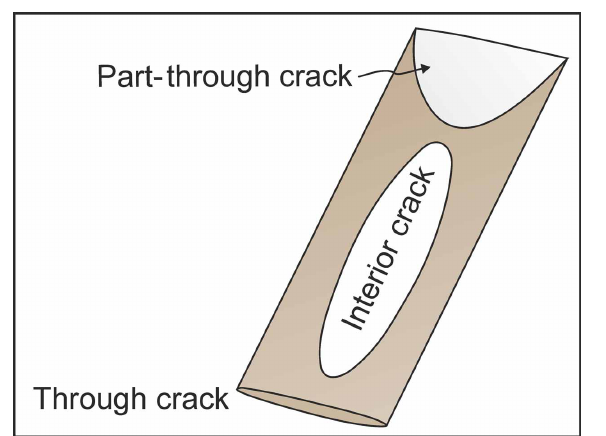
FIGURE 3 | Crack shapes of idealized two-dimensional fractures (when the aperture is neglected) used in modeling rock fractures in a reservoir: A through crack extends through the whole layer containing the crack, from one free rock surface to another. A part-through crack extends from a free surface of the rock body and partly into it. An interior crack is elliptical and located in the interior of the rock body hosting the crack, the body being regarded as infinite (modified from Gudmundsson, 2000b).